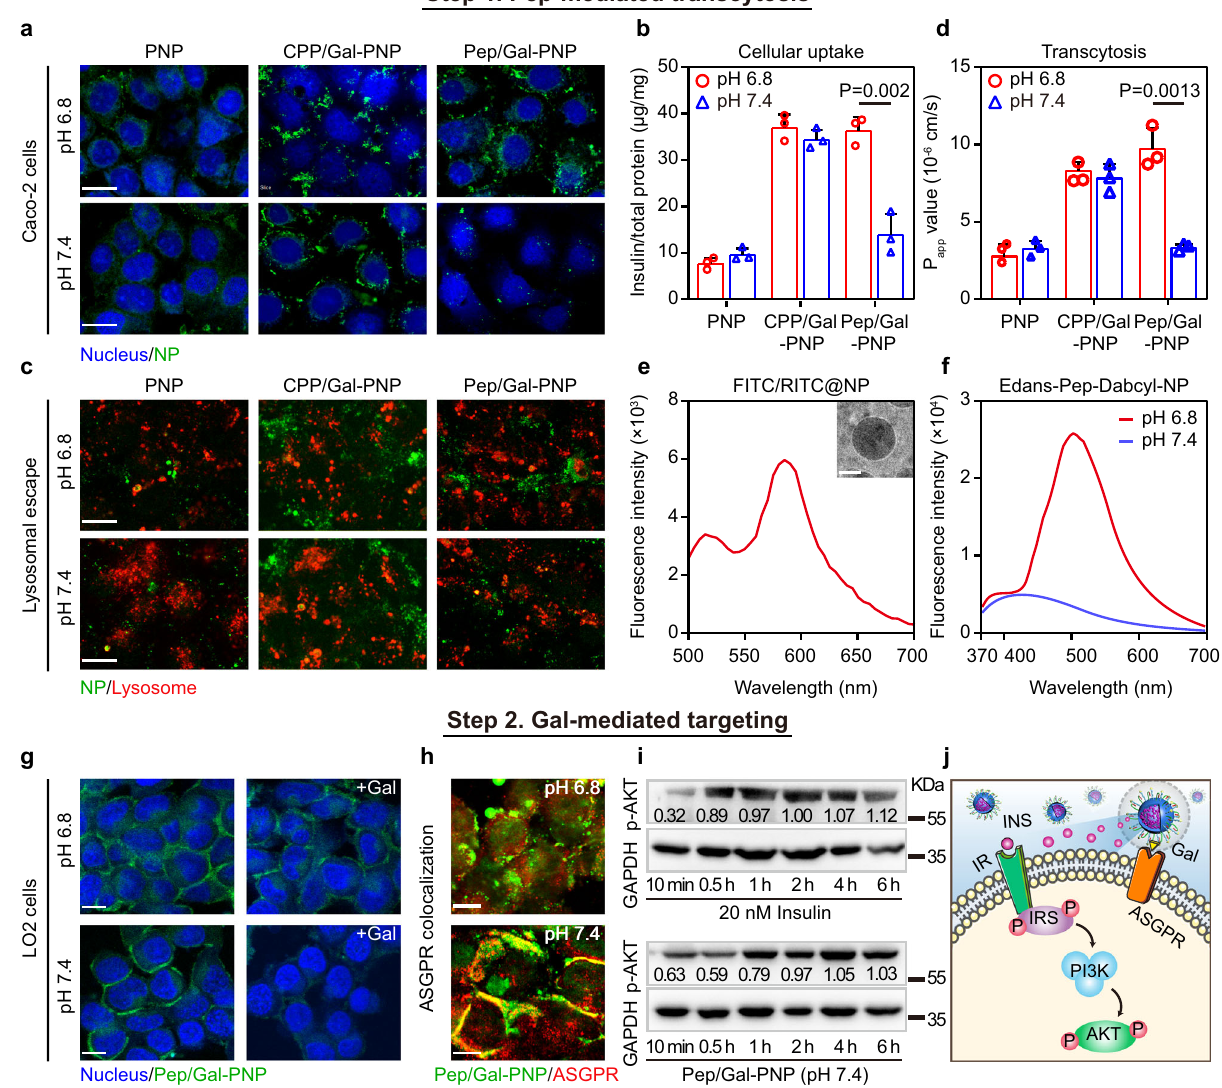
Fig.4|InvitrotransepithelialtransportandhepatocyteselectivityofPep/Gal- PNPs. a Cellular uptake of nanoparticles by Caco-2 cells. Scale bar: 10 μ m. b Quantitative analysis of nanoparticles internalized by Caco-2 cells. Data are pre- sented asthe mean±SD ( n =3 biologically independent experiments).** p =0.002, two-tailedStudent ’ s t -test. c Confocallaserscanningmicroscopy(CLSM)imagesof the colocalization of nanoparticles with lysosomes. Scale bar: 10 μ m. d Apparent permeabilitycoef fi cient(P app )valuesfornanoparticletransportacrossCaco-2cells. Data are presentedasthe mean±SD( n =3 biologically independent experiments). ** p =0.0013, two-tailed Student ’ s t -test. e Emission spectrum and cryo-TEM image ofFITC/RITC-loadedPep/Gal-PNPs(FITC/RITC@NP)collectedfromthebasolateral medium. Scale bar: 100nm.Scale bar: 100nm. f Emission spectra of Edans/Dabcyl-